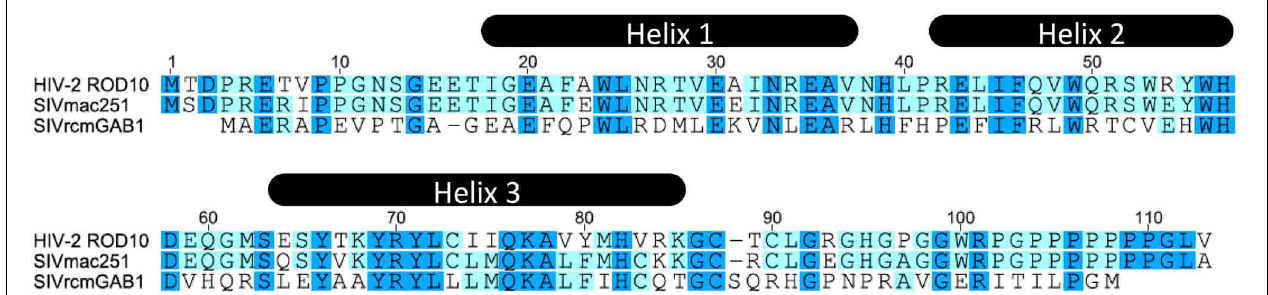
FIGURE 1 | HIV-2 ROD, SIVmac, and SIVrcm Vpx aminoacid sequence